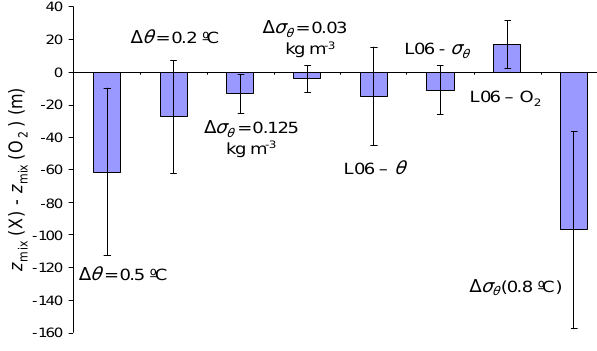
Fig. 4. Difference of objective O 2 -based z mix to subjective O 2 - based z mix and z mix based on two potential density threshold crite- ria applied to the CTD profiles in the Bellingshausen Sea.